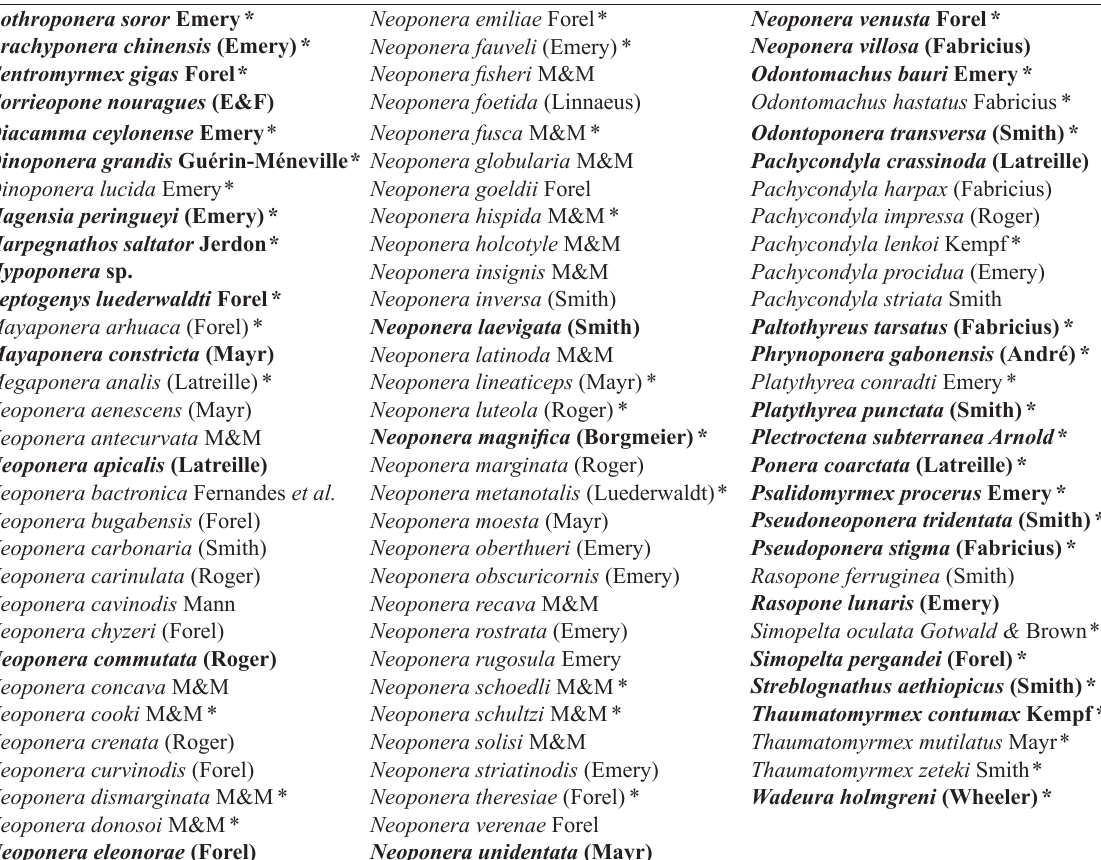
Table 1. Ponerine taxa examined. In bold: included in the phylogenetic analysis; * : only worker caste available; 1 , examined through SEM images from AntWeb; E&F: Esteves & Fisher; M&M: Mackay &